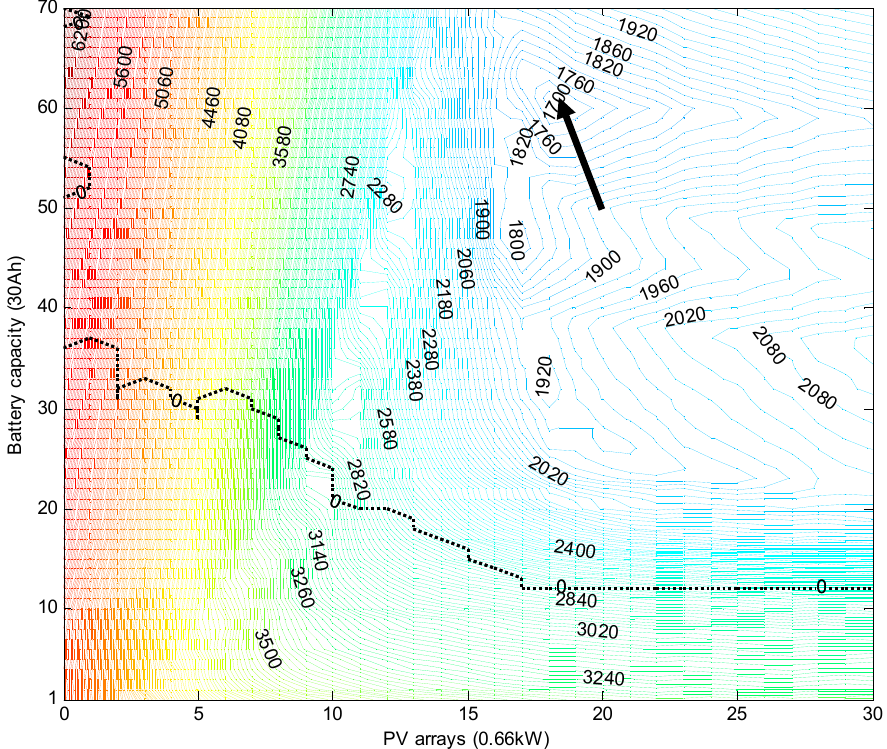
Figure 10. The reference plot of applying SWPHC to lab load.